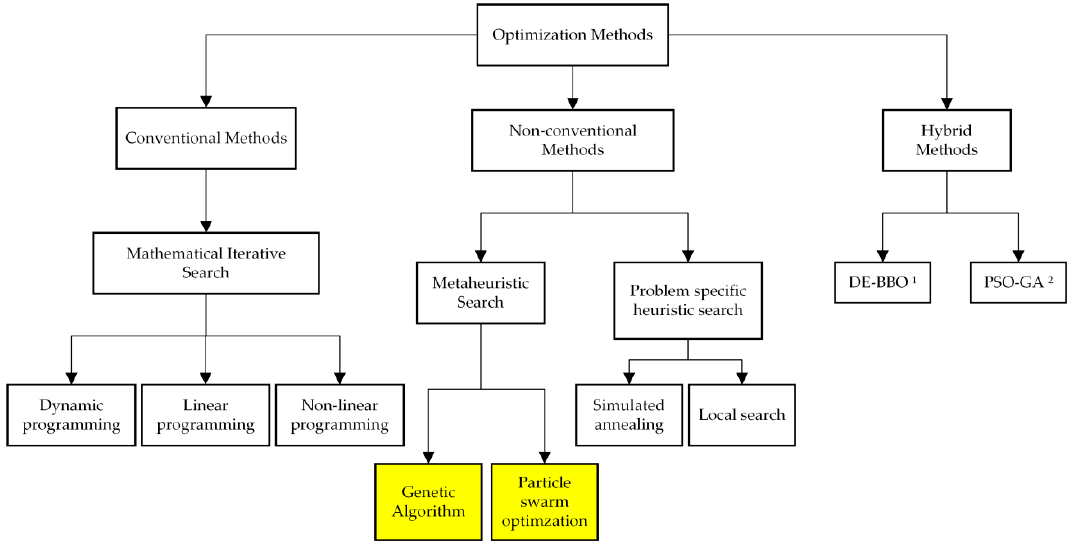
ff erential Evolution-Biogeography Based Optimization. 2 Particle Figure 1. Optimization methods. 1 Differential Evolution-Biogeography Based Optimization. 56 Figure 1. Optimization methods. 1 Di Swarm Optimization-Genetic